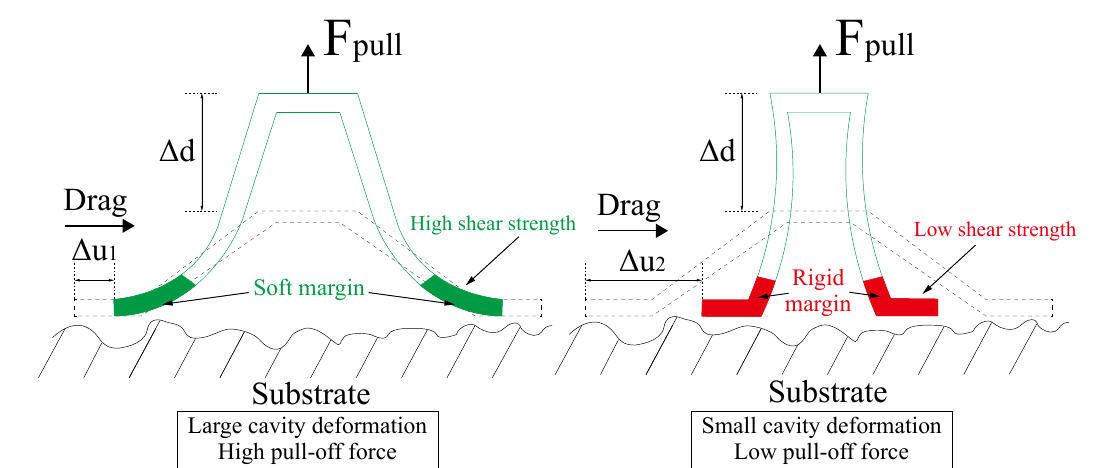
Figure 14. Deformation analysis of different discs.